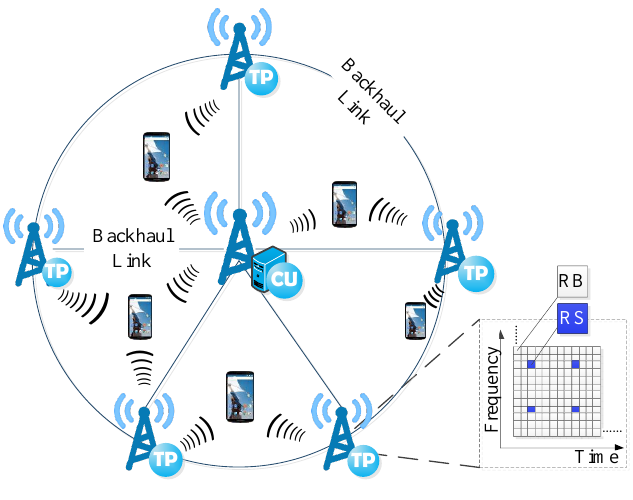
Figure 2. System model.